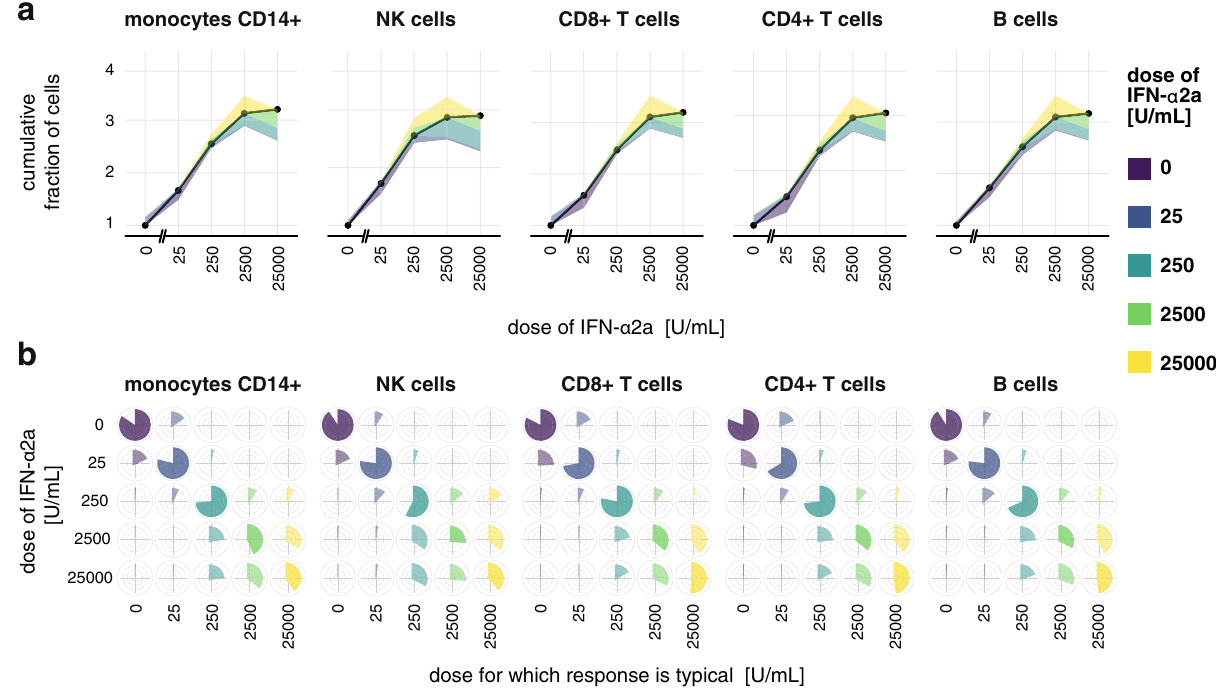
Fig. 3 Different types of PBMCs exhibit highly similar dose – responses to IFN- α 2a. a FRA of IFN- α 2a responses. Here, levels of all pSTATs were assumed to jointly constitute cell ’ s response. Supplementary Fig. 7 shows FRA for individual STATs. b Pie-charts of the cell-to-cell heterogeneity structure used to plot color bands in a . Cell-to-cell heterogeneity is shown as pie-charts, in addition to a , in order to clearly visualize the similarity between the cell types. Technical details: The plot presents an analysis of one biological replicate. The analysis of the second biological replicate yielding very similar results is shown in Supplementary Fig.